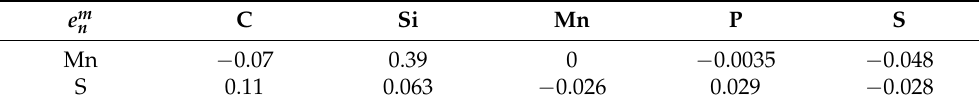
Table 5. Interaction coefficients of different elements in molten steel at 1873 K [6,35].